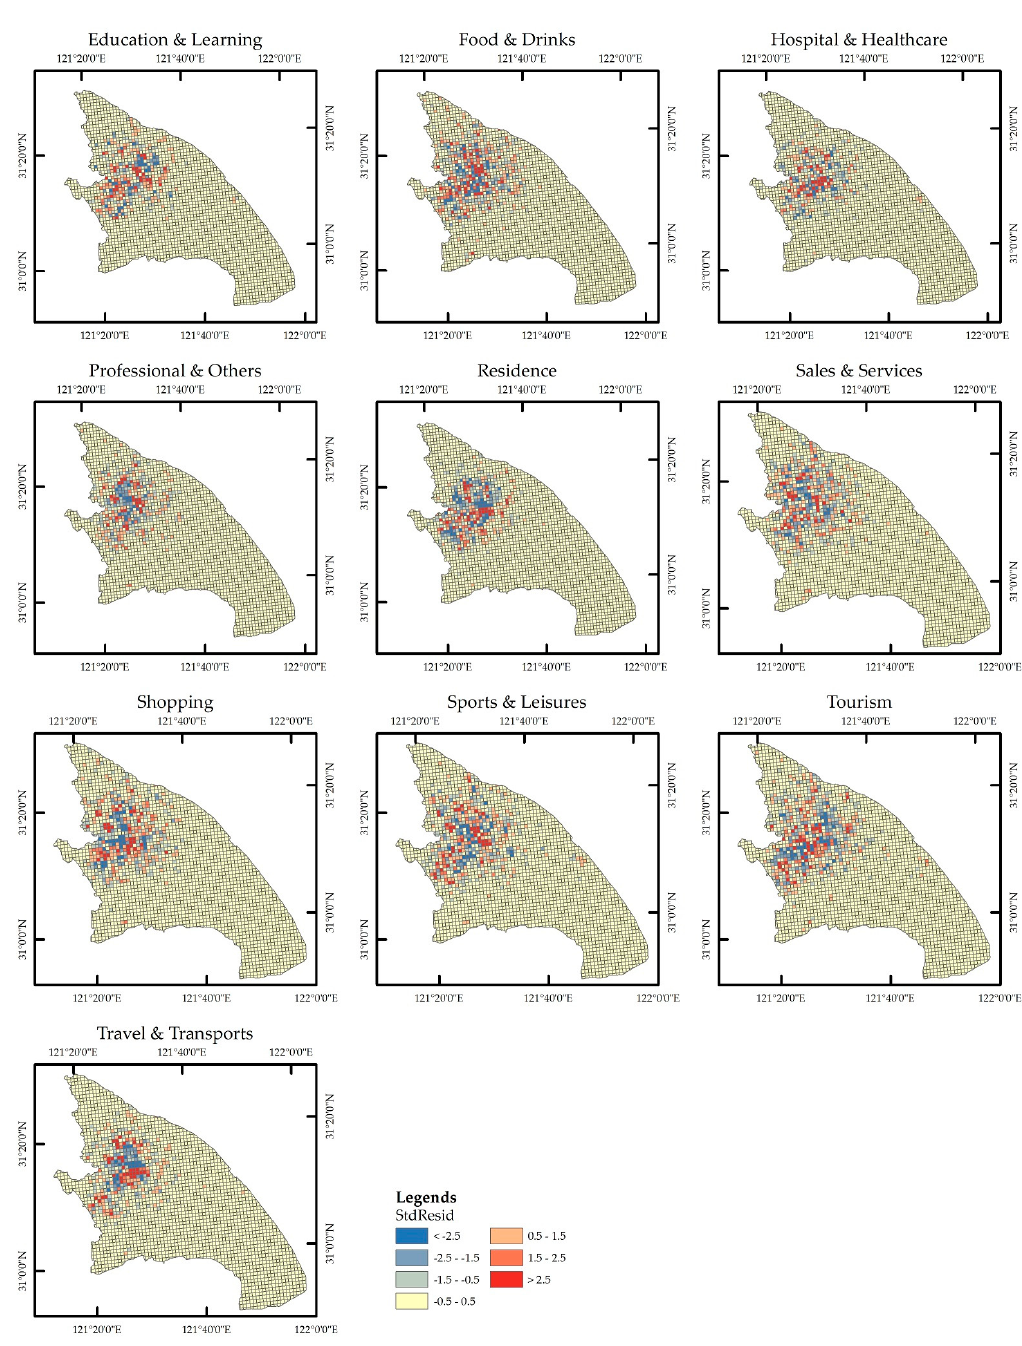
Figure 13. Spatial distribution of activities by the men in Shanghai.